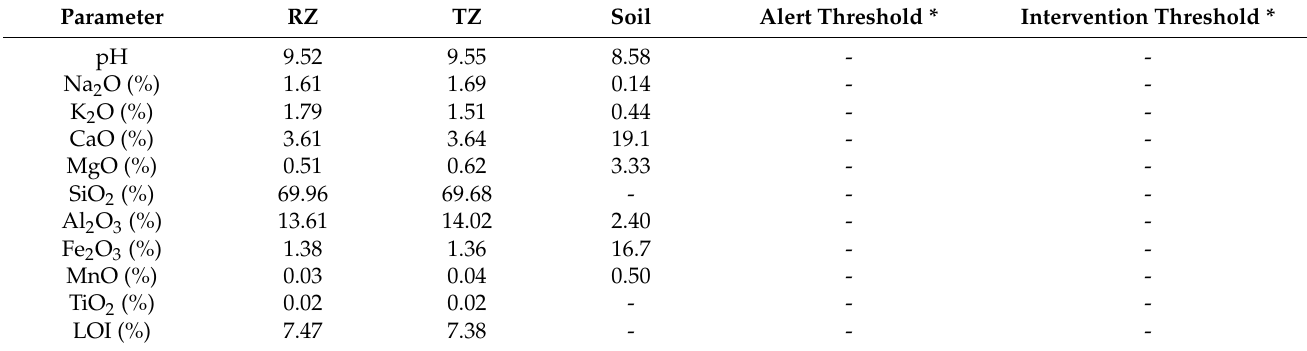
Table 1. Physico-chemical properties of the raw (RZ) and thermally treated (TZ) zeolites and